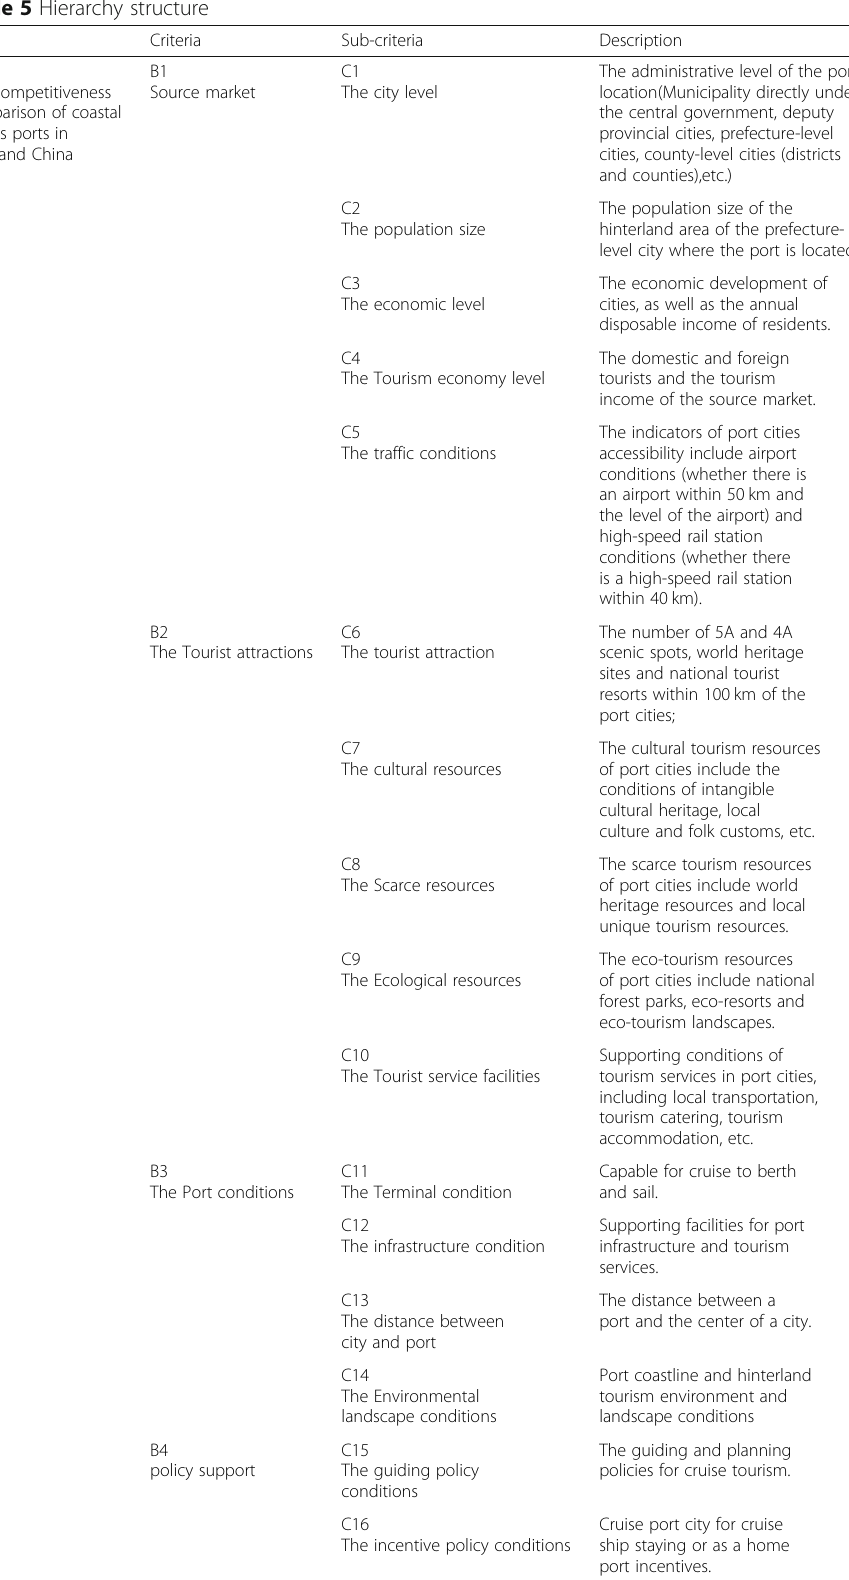
Table 5 Hierarchy structure